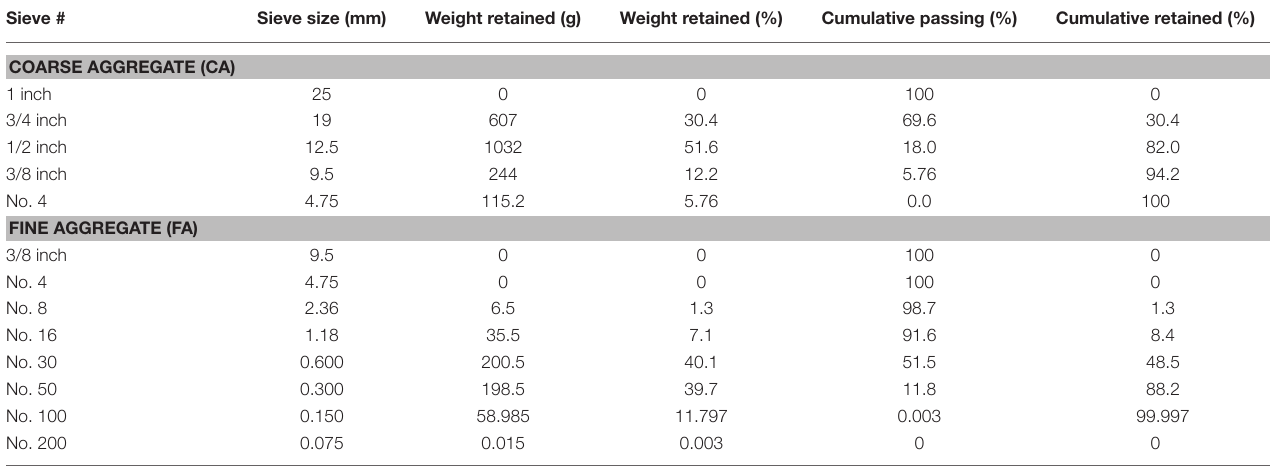
TABLE 2 | Grain size distribution of coarse and fine aggregates (ASTM C 33).